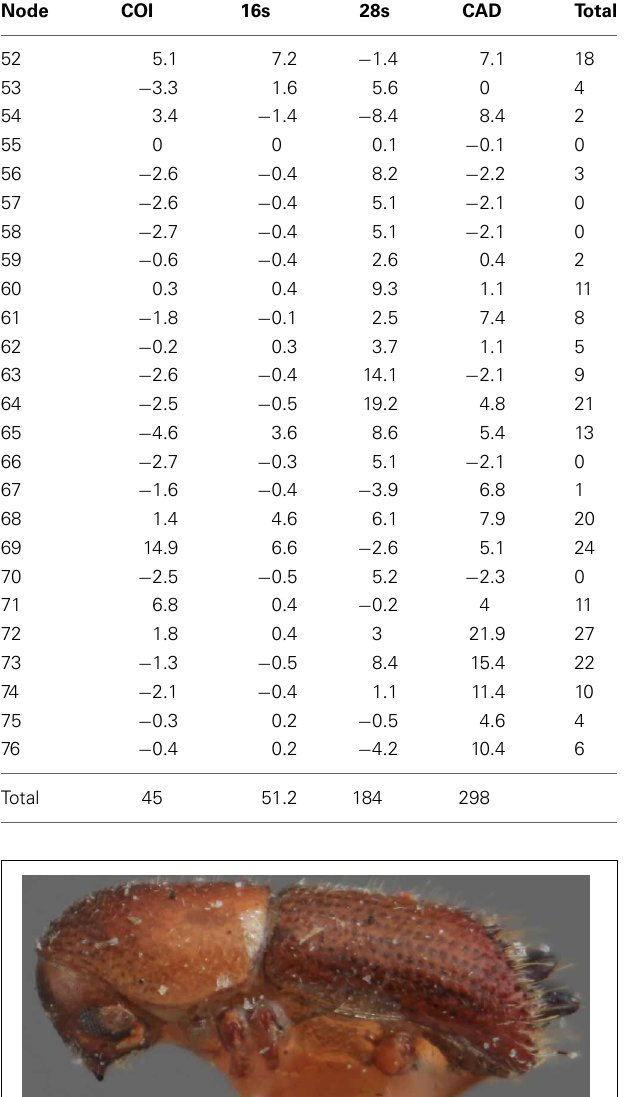
Table 5 | Partition bremer support for 1 of 756 most parsimonius trees reconstructed with the MUSCLE aligned data (Figure 2).